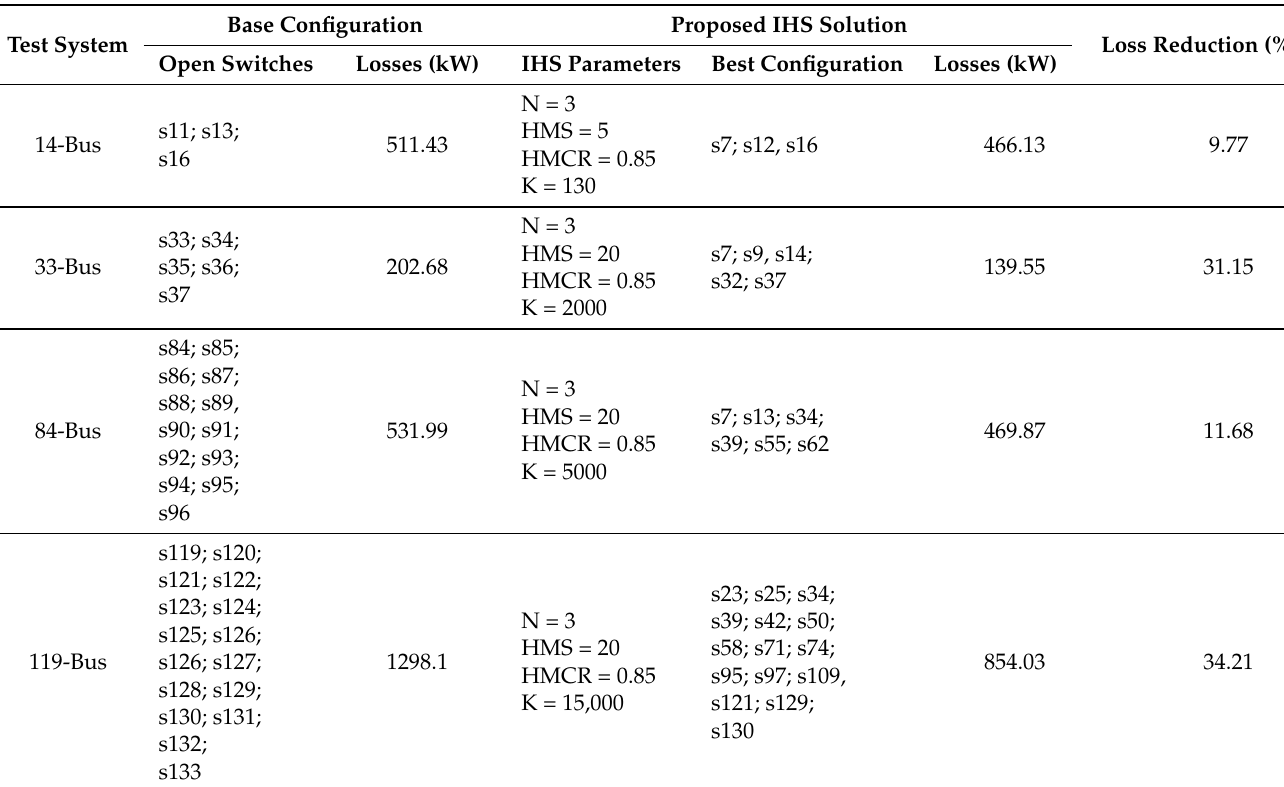
Table 1. Results obtained for different test systems.